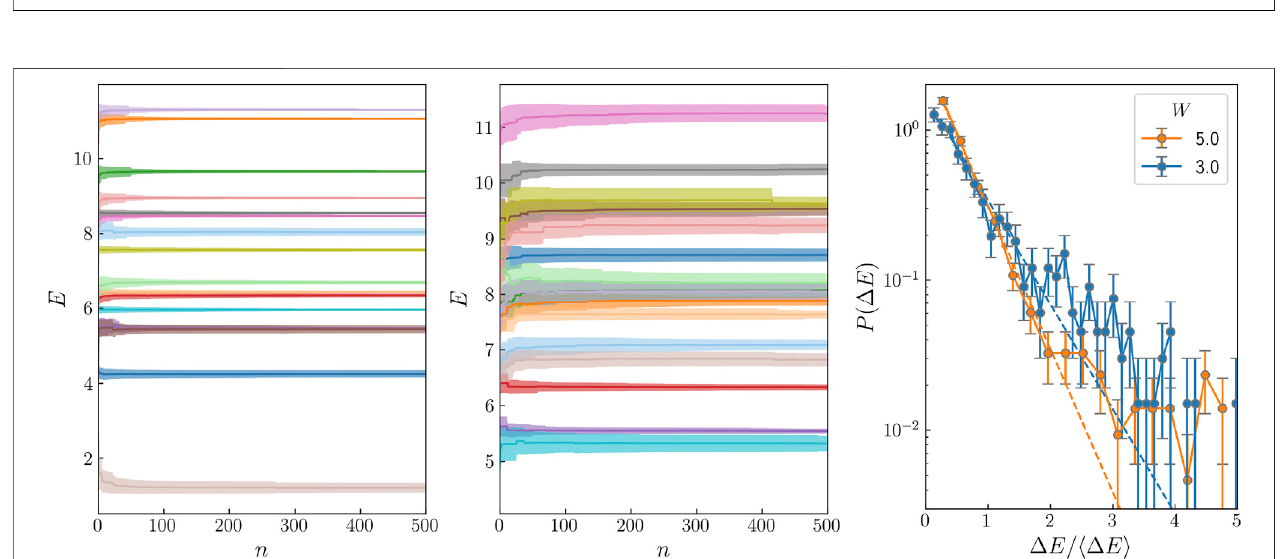
FIGURE 1 | (A) Energy obtained for the different states generated with our method versus the exact energy E panel: E − E exact versus E exact . (B) IPR of the states in panel (A) for disorder 3 for the exact calculation and for our algorithm. (C) Energy level spacing distribution for the same parameters as in (A) .